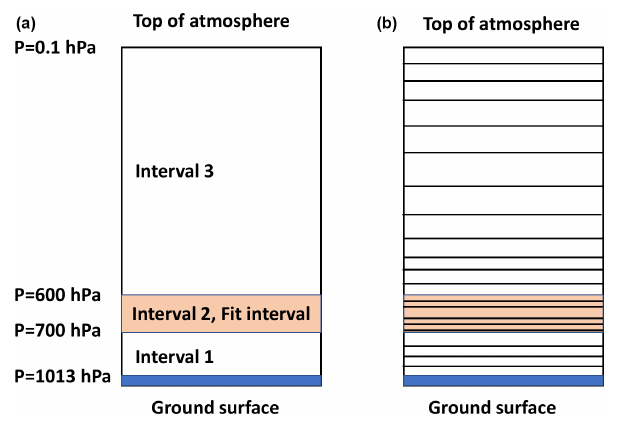
Figure 3. Definition of directions in DISAMAR. θ 0 and φ 0 are the solar zenith angle and the solar azimuth angle, respectively, and θ and φ are the satellite viewing zenith angle and satellite azimuth an- gle, respectively. The relative azimuth angle is φ − φ 0 . In the super- matrices we use µ 0 = cos θ 0 and µ = cos θ